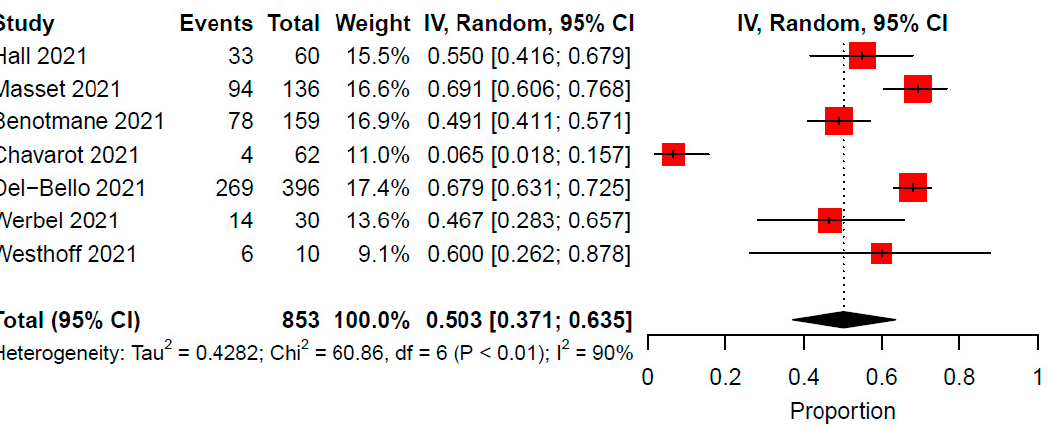
Figure 2. Proportion of antibody response after the third COVID-19 vaccine dose among solid organ transplant recipients. CI, confidence interval; IV, inverse variance.